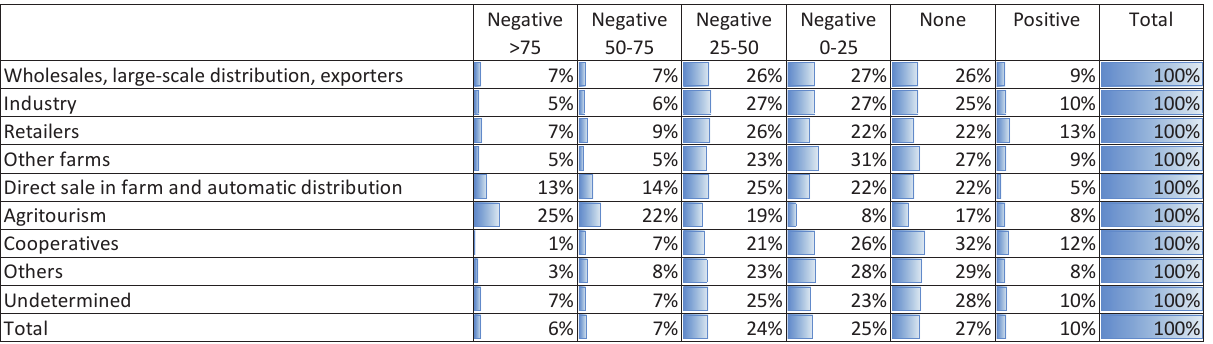
Table 2. Expected changes in Total Output by sales channel for the surveyed farms.